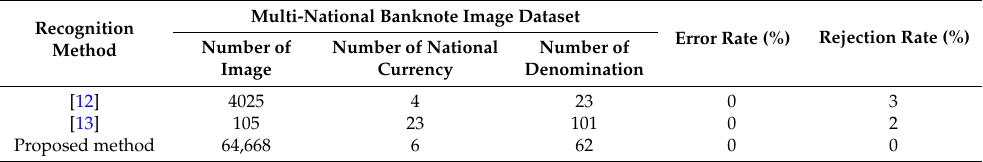
Table 7. Comparison of recognition accuracy of the proposed method and previous studies on multi-national banknote